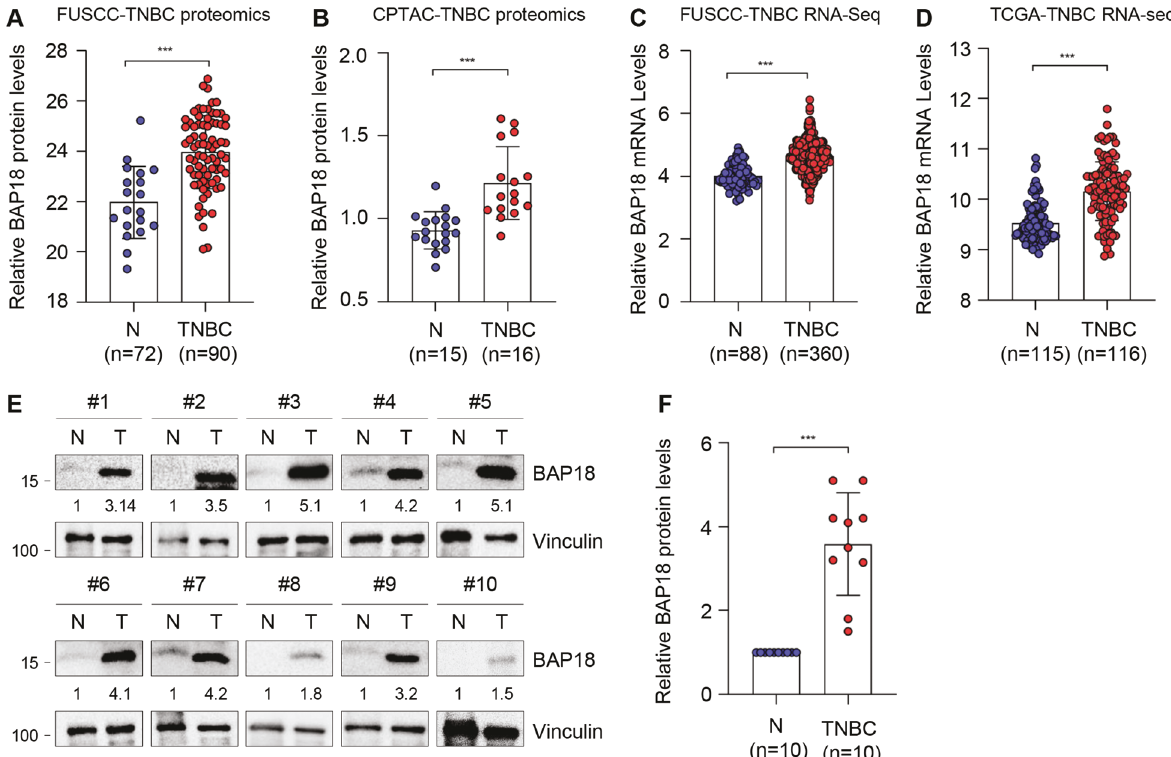
Fig. 1 Expression levels of BAP18 are upregulated in TNBC tissues. A Relative BAP18 protein levels in FUSCC-TNBC proteomic assays. FUSCC, Fudan University Shanghai Cancer Center. N, Normal tissues. B Relative BAP18 protein levels in CPTAC database. C Relative BAP18 mRNA expression levels in FUSCC-TNBC RNA-seq dataset [35]. D Relative BAP18 mRNA Levels in TCGA RNA-seq database. E , F Cellular lysates from 10 pairs of primary TNBC specimens and matched adjacent normal tissues were subjected to immunoblotting analysis with an anti-BAP18 antibody. Representative immunoblotting images are shown in E and corresponding quantitative results are presented in F . Quantitation of immunoblotting bands was performed using Image J software, and expression levels of BAP18 were normalized to those of Vinculin. *** p <